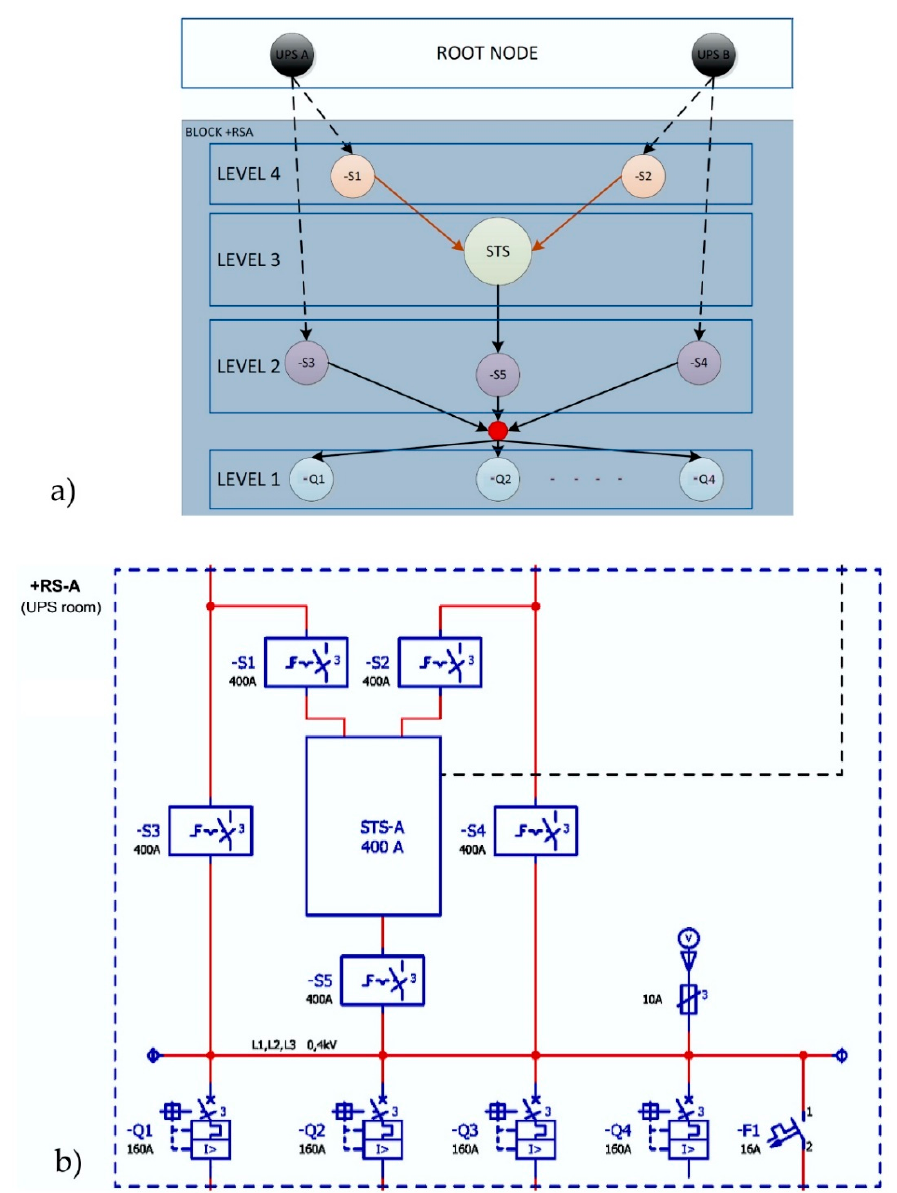
Figure 2. ( a ) Node tree diagram with internode. ( b ) Power Supply Block.